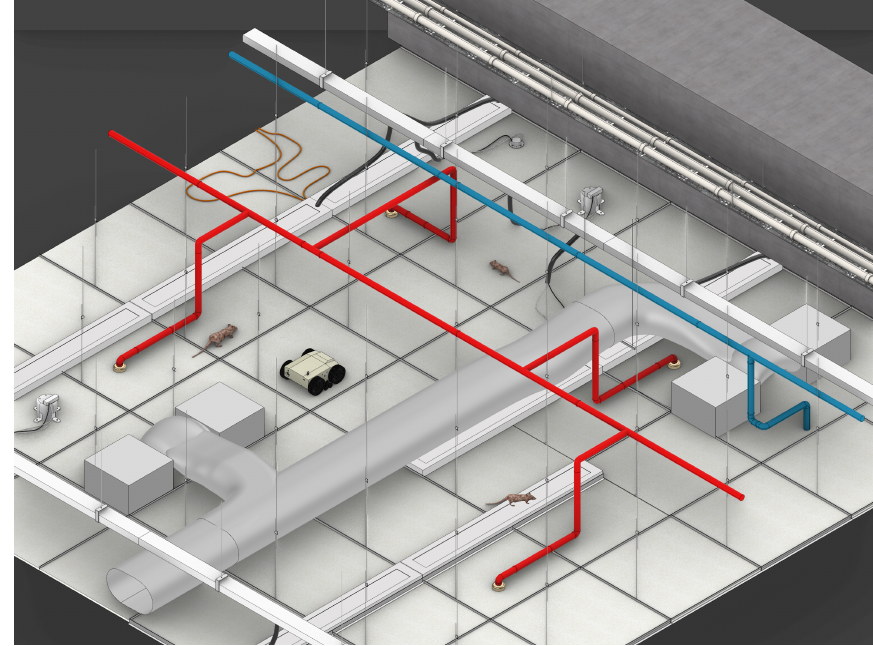
Figure 2. Overview of false ceiling inspection method using the Falcon robot.